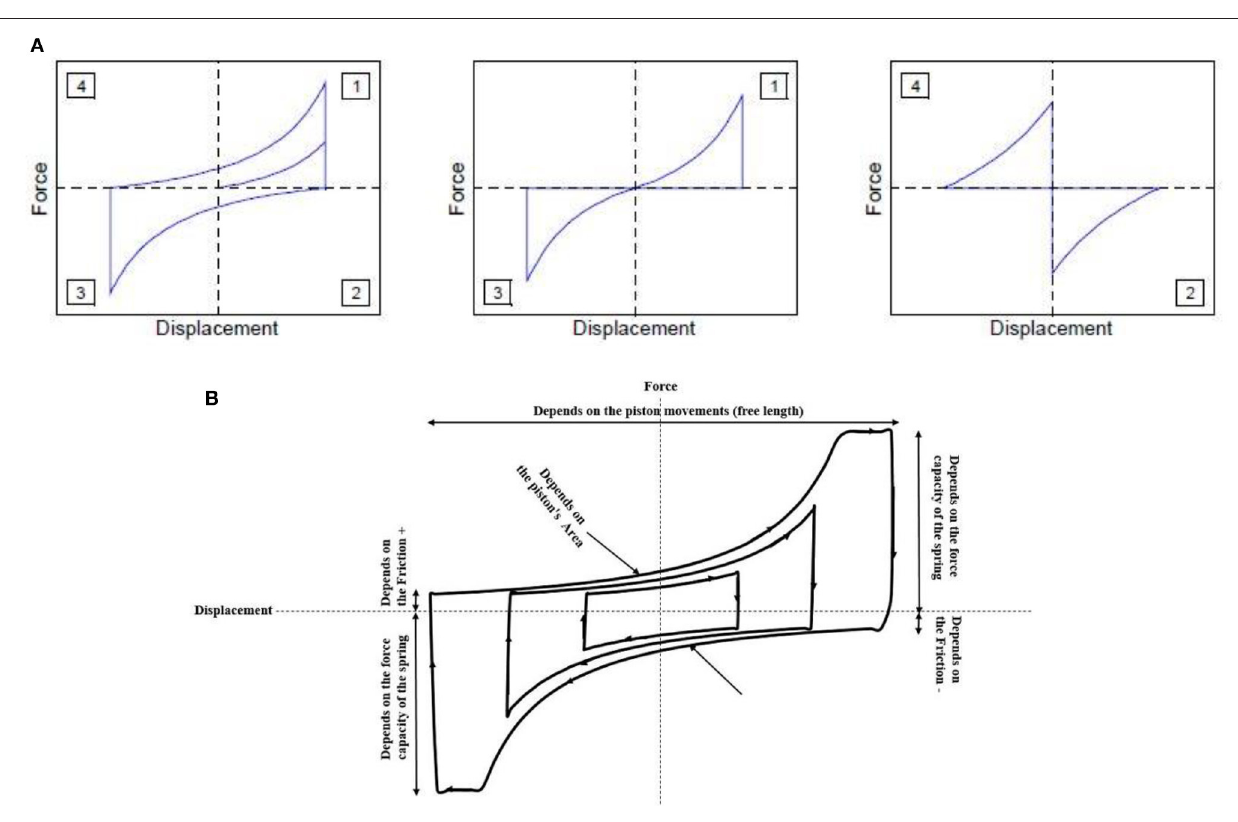
FIGURE 4 | (A) Example of constitutive law for the air-cylinder semi-active damper (Franco-Anaya et al., 2014). (B) The modified constitutive model of semi-active damper spring for the application to represent masonry infill